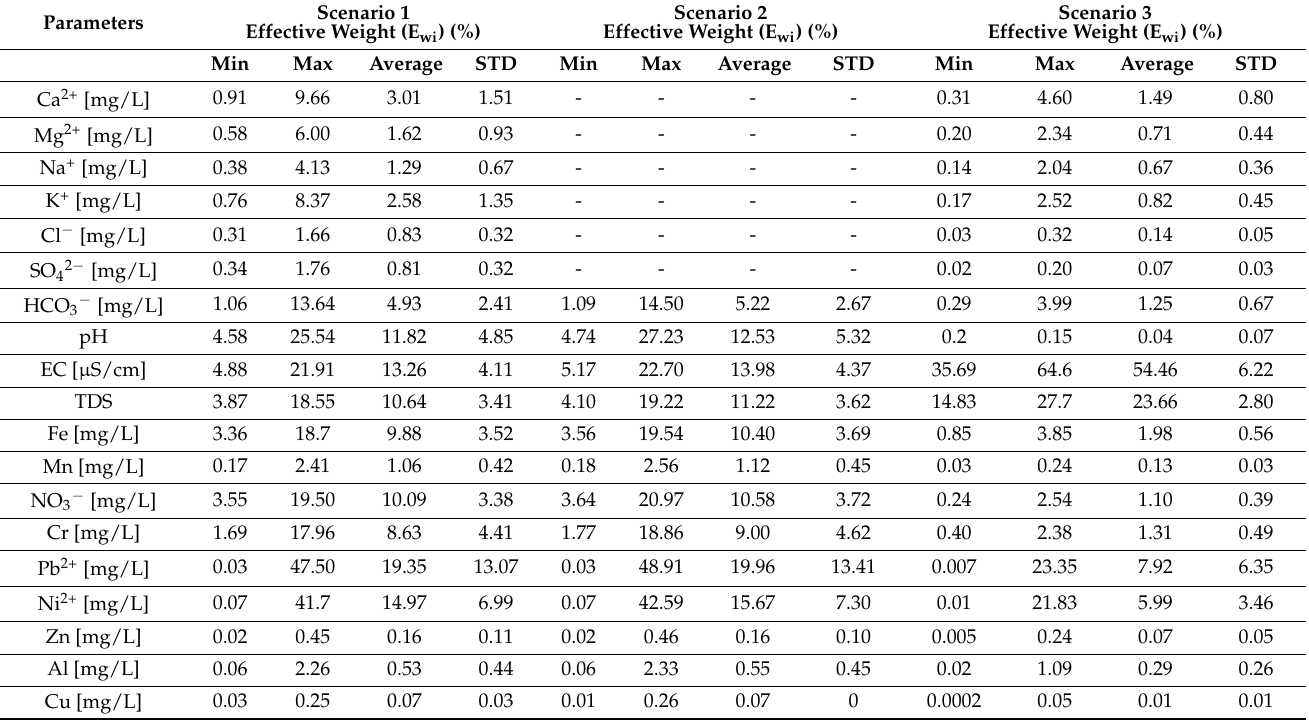
Table 5. Descriptive statistics of effective weights for each